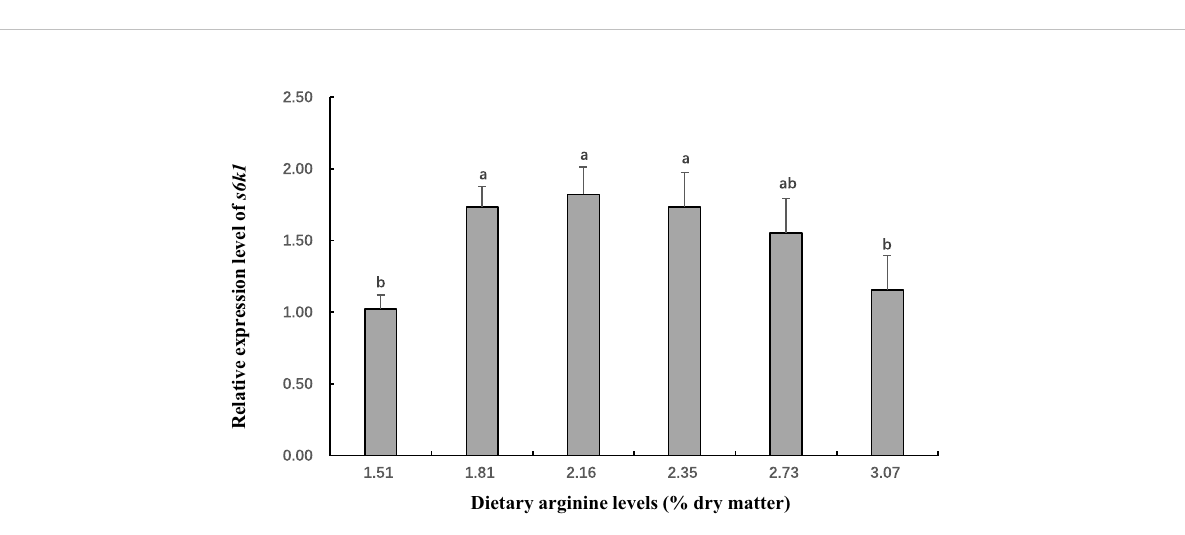
FIGURE 5 The gene expression (S6 kinase-polypeptide 1 ( s6kl ) in muscle) of postlarval Scylla paramamosain fed diet with different arginine levels. Means in the same row with different superscripts are signi fi cantly different (P<